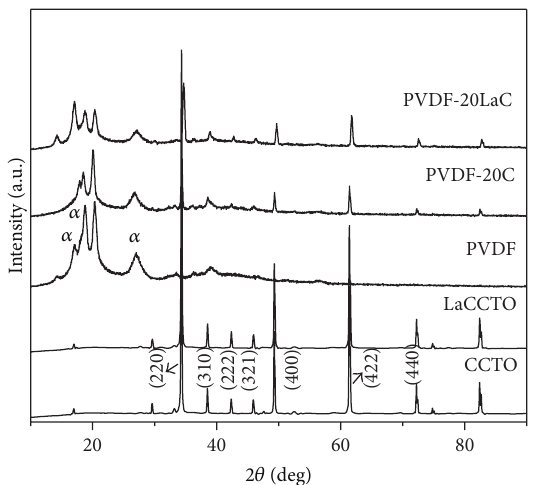
Figure 1: X-ray diffraction patterns for CCTO, pure PVDF, PVDF- 20C, and PVDF-20LaC